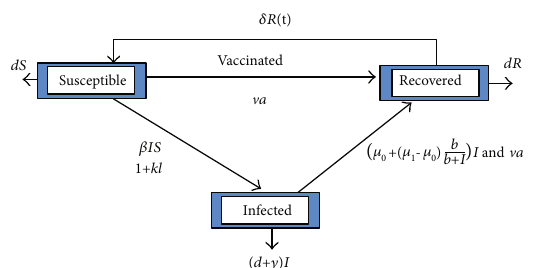
Figure 6: Schematic diagram of the modi fi ed model. The arrows represent a progression from one compartment to the next and death rates.